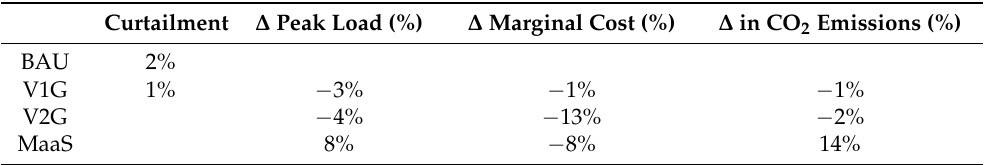
Table 1. Short-term impact of EV charging on the selected key performance